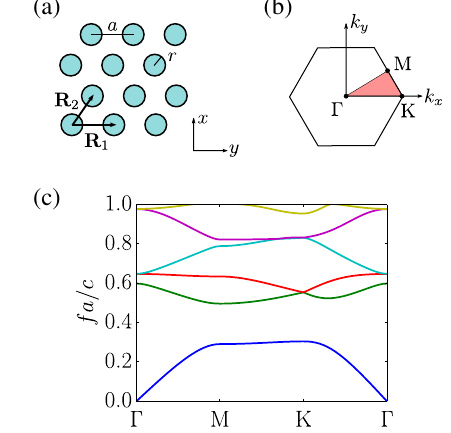
FIG. 2. Propagation in the 2D triangular lattice of sapphire discs (a) is forbidden for TM electromagnetic waves with frequencies near 0 . 4 c=a because of the band gap (c). Lattice vectors R 1 and R 2 , interdisc spacing a , and disc radius r are defined in (a). The first Brillouin zone of the reciprocal lattice is identified in (b) by the hexagon; the irreducible Brillouin zone is shaded and represents the entire Brillouin zone by symmetry. The dispersion curves for the lowest-frequency bands along the path outlining the shaded region in (b) are shown in (c) for r ¼ 0 . 17 a . Calculations were performed using the MIT Photonic Bands simulation code [28]. The dielectric constant of sapphire is anisotropic; in the case of Fig. 4, the c axis of the sapphire is oriented along z .